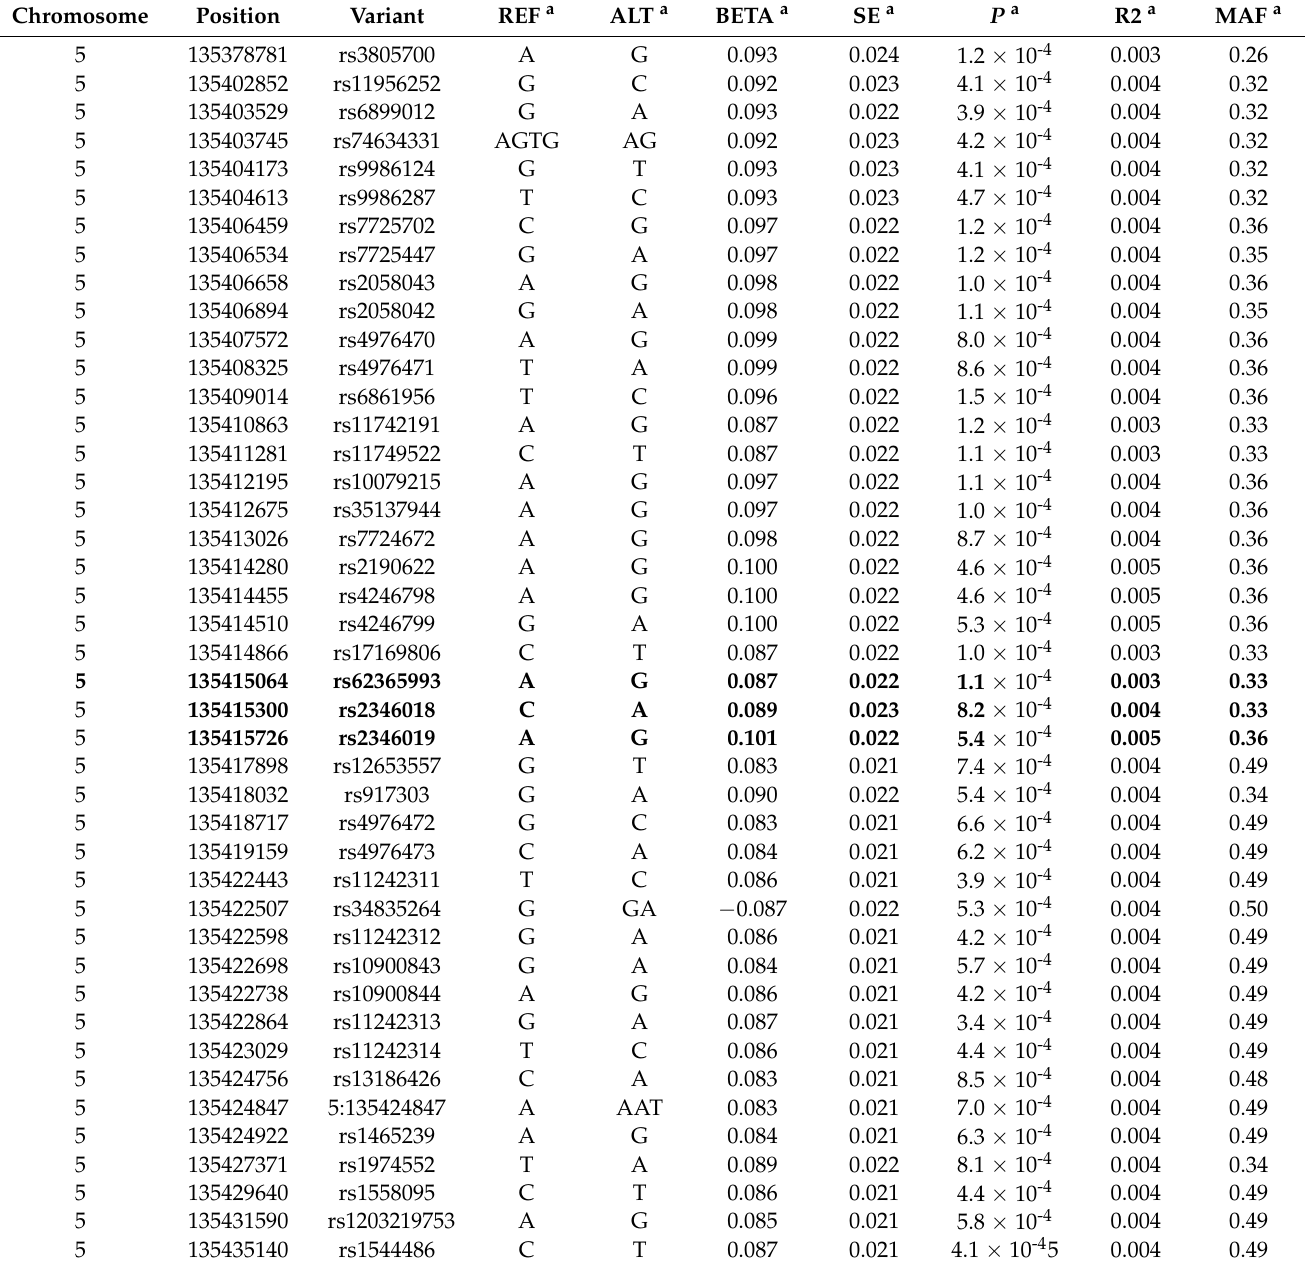
Table 2. Strongest mQTLs within 50 kb of cg06536614 (46 variants for the analysis of